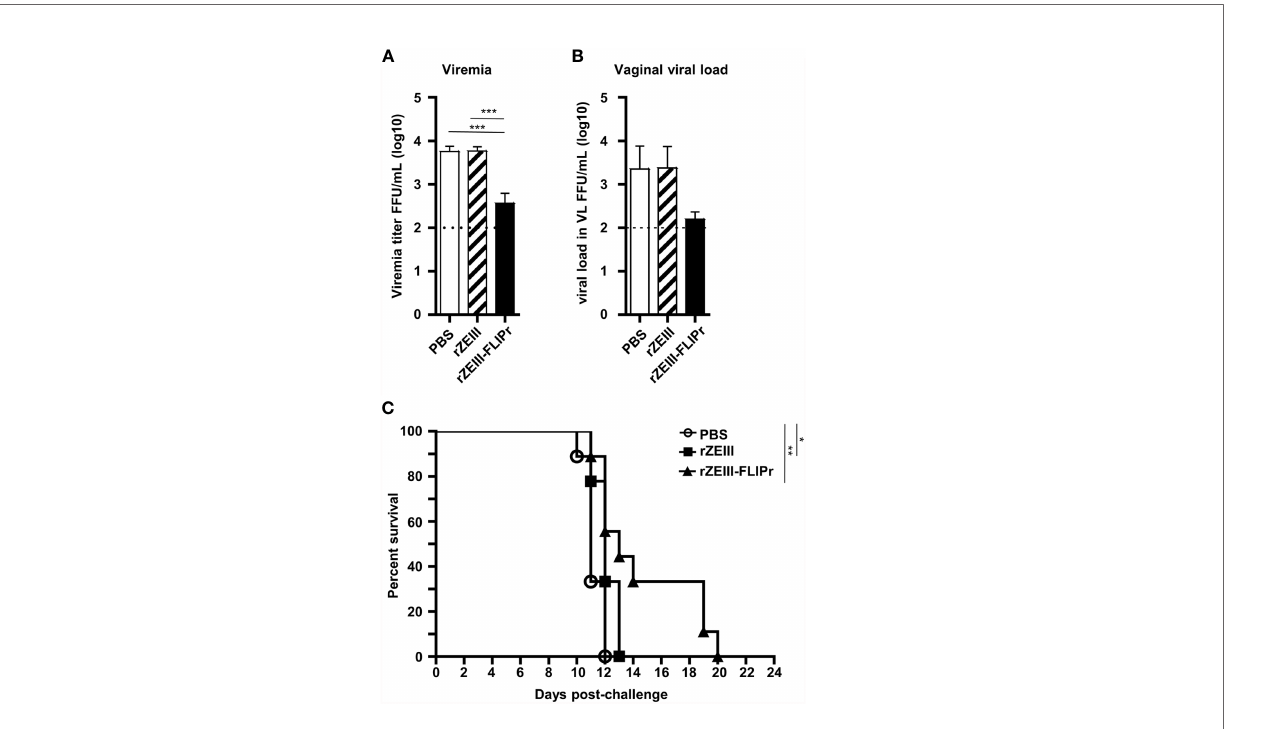
FIGURE 6 | Protective effects induced by intranasal administration of rZEIII-FLIPr. Groups of immunode fi cient AG129 mice (n = 9/group) were intranasally administered PBS, rZEIII, or rZEIII-FLIPr (30 m g per dose) 3 times at two-week intervals. All animals were intraperitoneally injected with 80 FFUs of Zika virus (PRVABC59) in 0.2mL of PBS at 6 weeks after the fi rst administration. (A) Plasma and (B) VL samples were collected 3and 4 days after virus challenge, respectively. The viral titers were evaluated by focus-forming assays. The viral titers were logarithmically transformed before statistical analyses. Data represent the mean ± SE of the mean. Statistical signi fi cance was determined using the Kruskal-Wallis test with Dunn ’ s multiple comparison test. ***p<0.001. (C) The overall survival of the mice is shown. Survival analysis was calculated by Log-Rank test. *p<0.05.